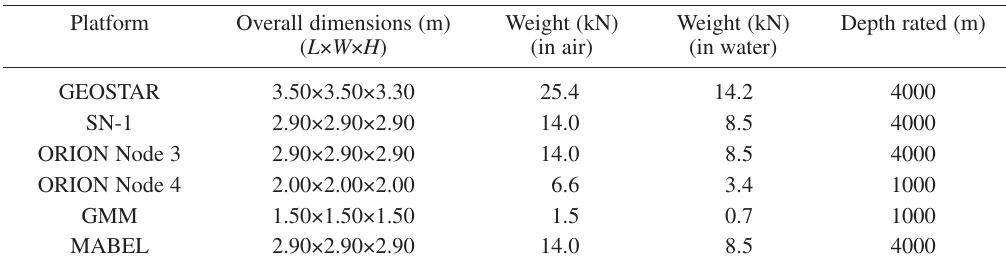
Table V. List of the GEOSTAR-class platforms and some